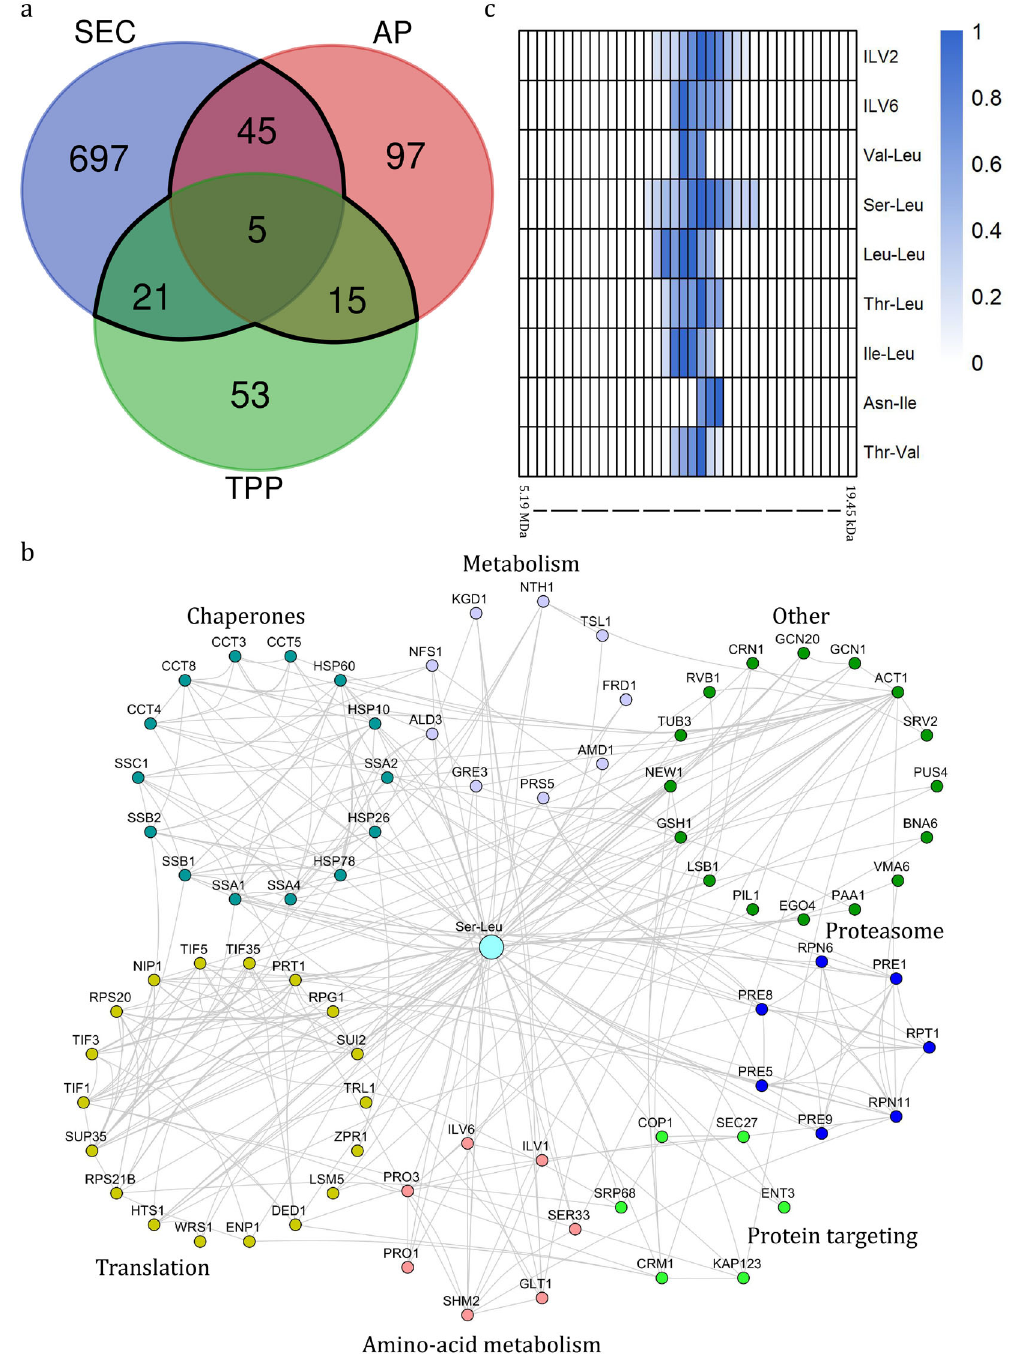
Fig. 4 Characterisation of Ser-Leu interactome. a Venn diagram showing the number of putative Ser-Leu targets identi fi ed using size exclusion chromatography (SEC), af fi nity puri fi cation (AP) and thermal proteome pro fi ling (TPP) (Supplementary Data S12, S13 and S17). An overlap between at least two orthogonal approaches (86 proteins) was considered to represent the Ser-Leu interactome and is marked in black. b The Ser-Leu interactome network. Edges represent protein – protein interactions and were imported from STRING, based on the experimental evidence (score ≥ 0.4). Functionally related proteins are grouped together. Distinct colours are used to mark different protein groups. c Heatmap showing co-elution of catalytic (Ilv2) and regulatory (Ilv6) subunits of the acetolactate synthase complex with dipeptides containing branched-chain amino acids (Supplementary Data S6 and S7). The intensity was calculated relative to the maximum intensity measured across the SEC fractions. The theoretical molecular weight was calculated using reference